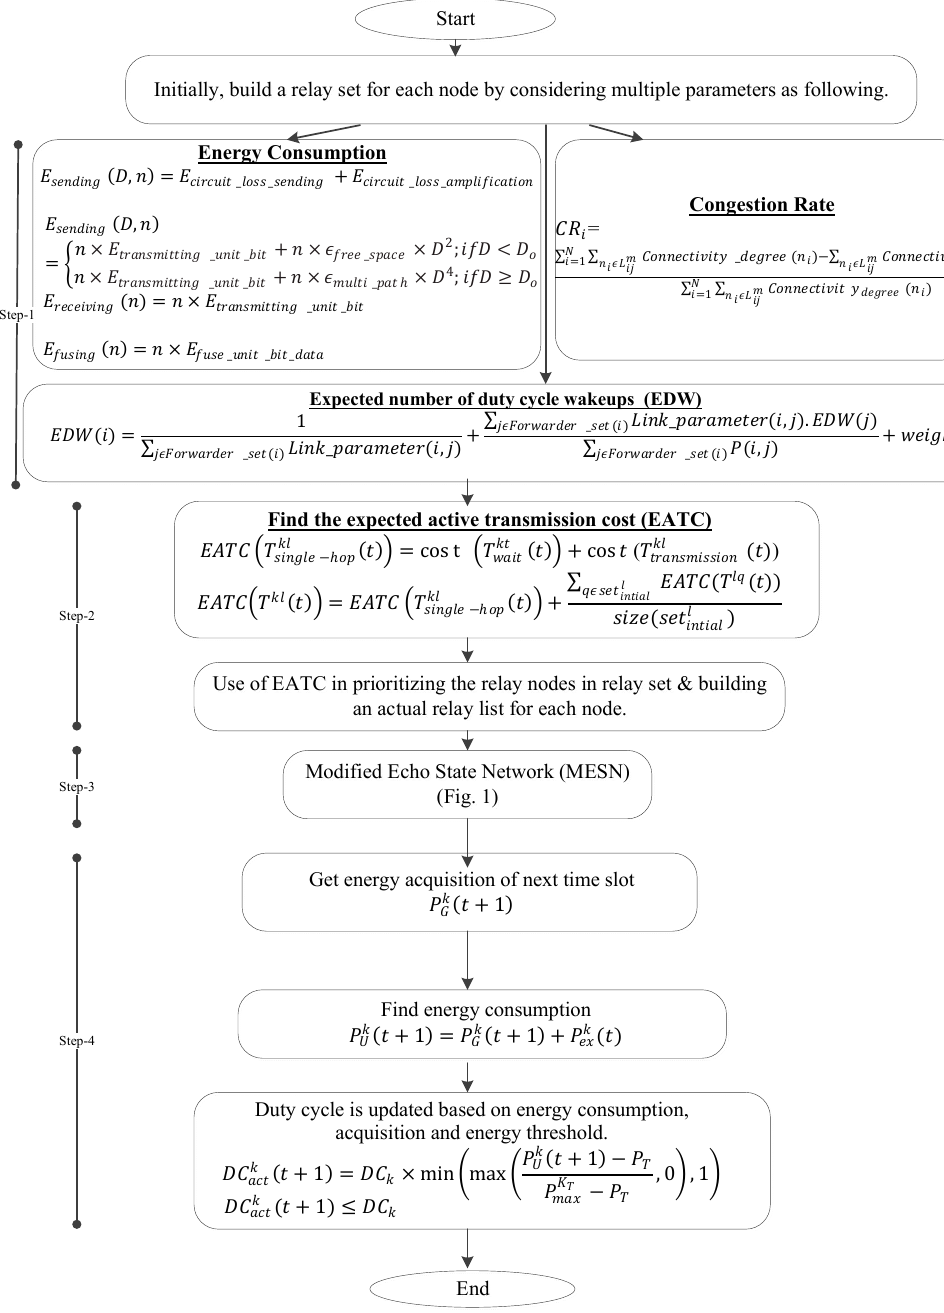
Figure 3. The working structure of the proposed modified echo state network (MESN) based dynamic duty cycle (DC) with optimal opportunistic routing (OOR).